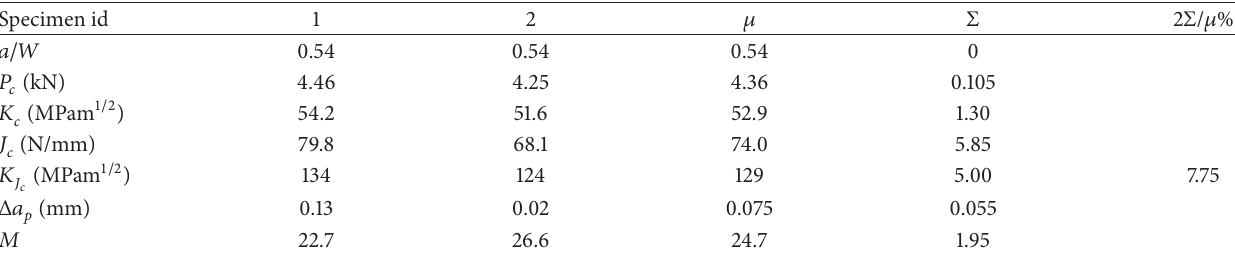
Figure 10: 𝑃 - 𝑉 𝑔 diagram of the 10t SE(B) specimens (S55C steel, 20 ∘ C): 𝐾 𝐽 fracture followed after relatively large plastic deformation. 𝑐 Table 2: Fracture toughness test results of 10t SE(B) specimens (S55C steel, 20 ∘ C). Here, 𝜇 and Σ denote the mean and standard deviation of each parameter, respectively. Though 𝑀 was smaller than 30, cleavage fracture with negligible stable crack extension was